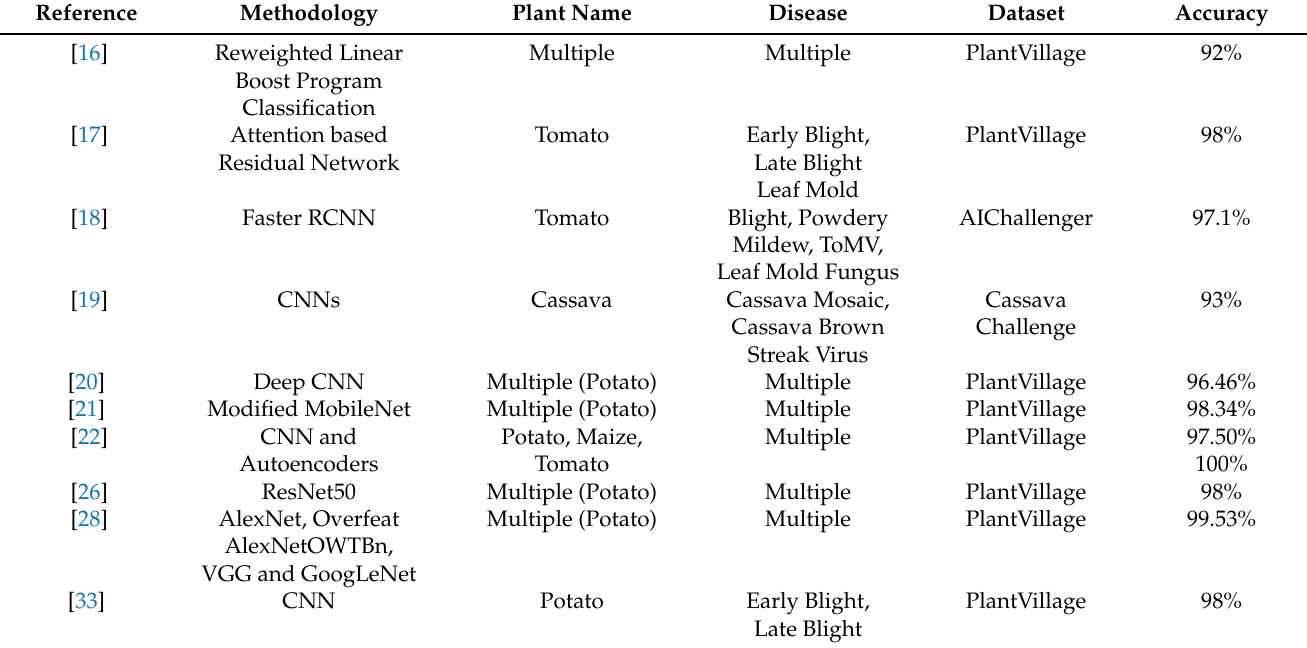
Table 1. Summary of related